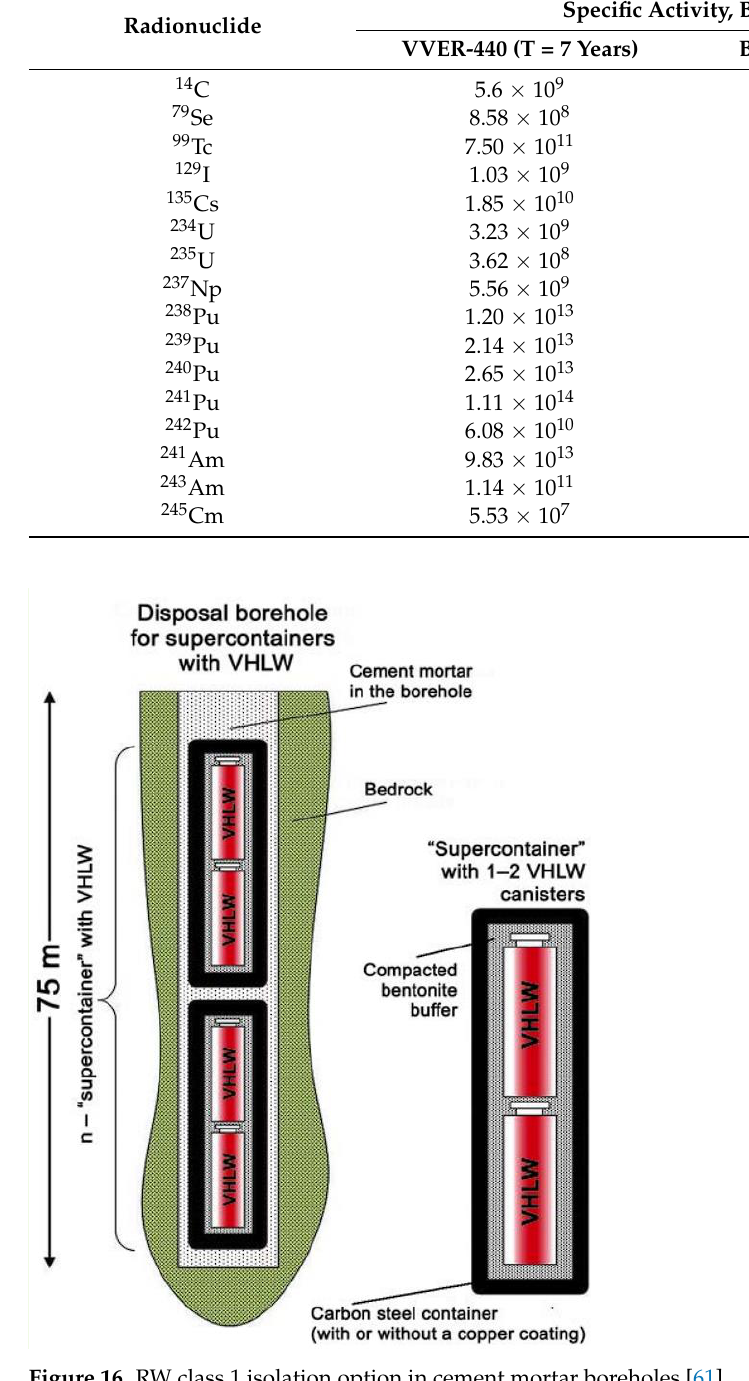
Figure 16. RW class 1 isolation option in cement mortar boreholes